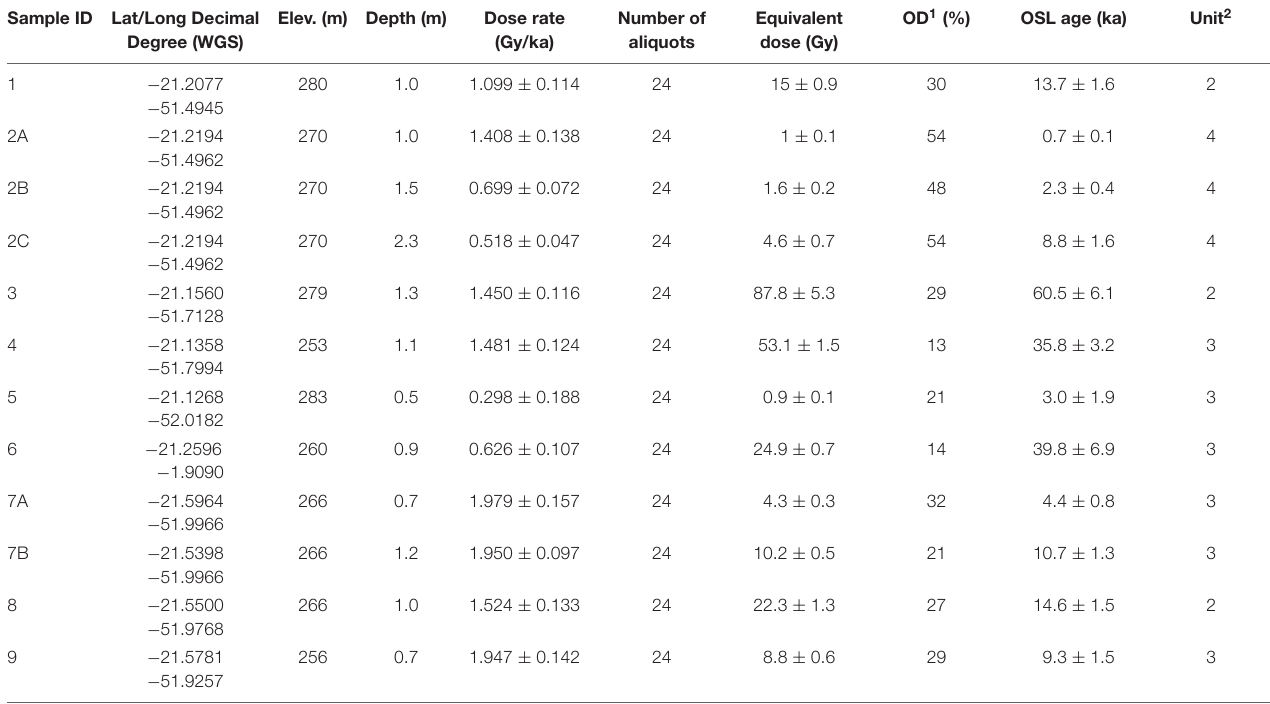
TABLE 3 | Data summary of the OSL dating: equivalent doses, dose rates and ages. Sample ID Lat/Long Decimal Degree